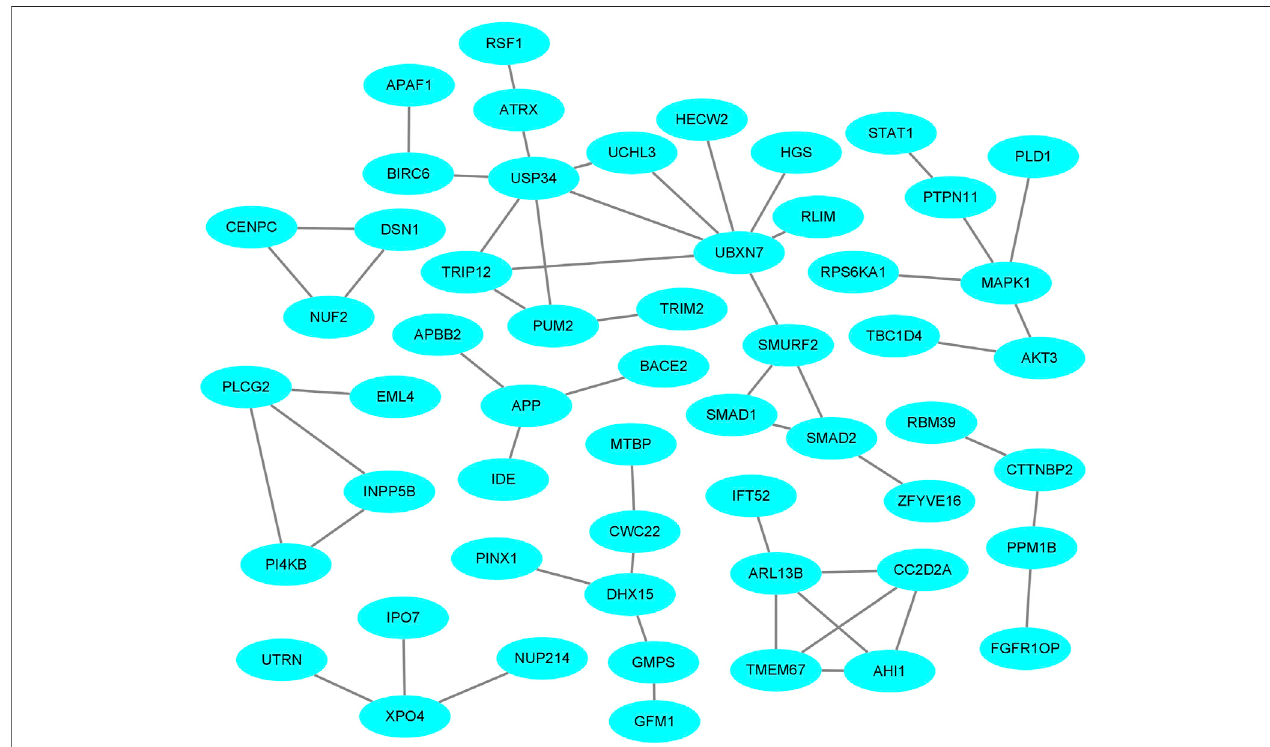
FIGURE 7 | The protein-protein interaction (PPI) network of host proteins with DE circRNAs in the comparisons.